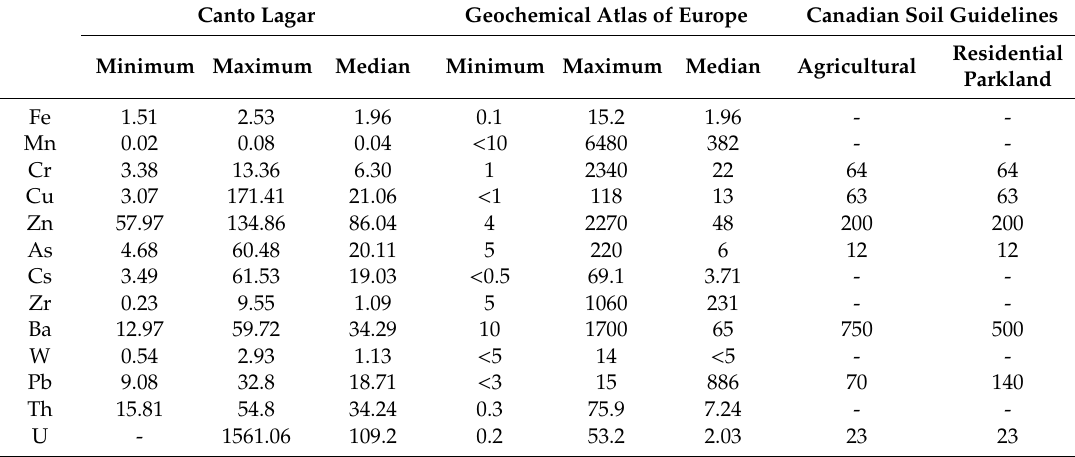
Table 5. Comparison of potentially toxic elements values of soil from Canto Lagar area with European values and reference values of Canadian